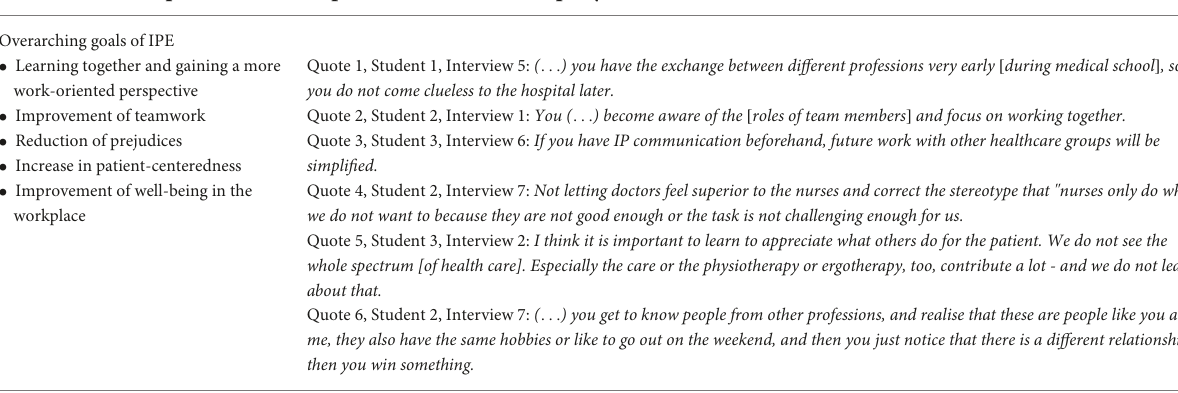
TABLE 2 Subcategory other views elements and representative cites.